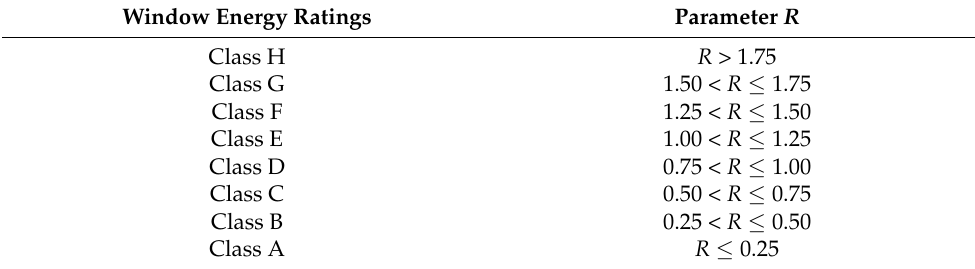
Table 4. Windows’ energy